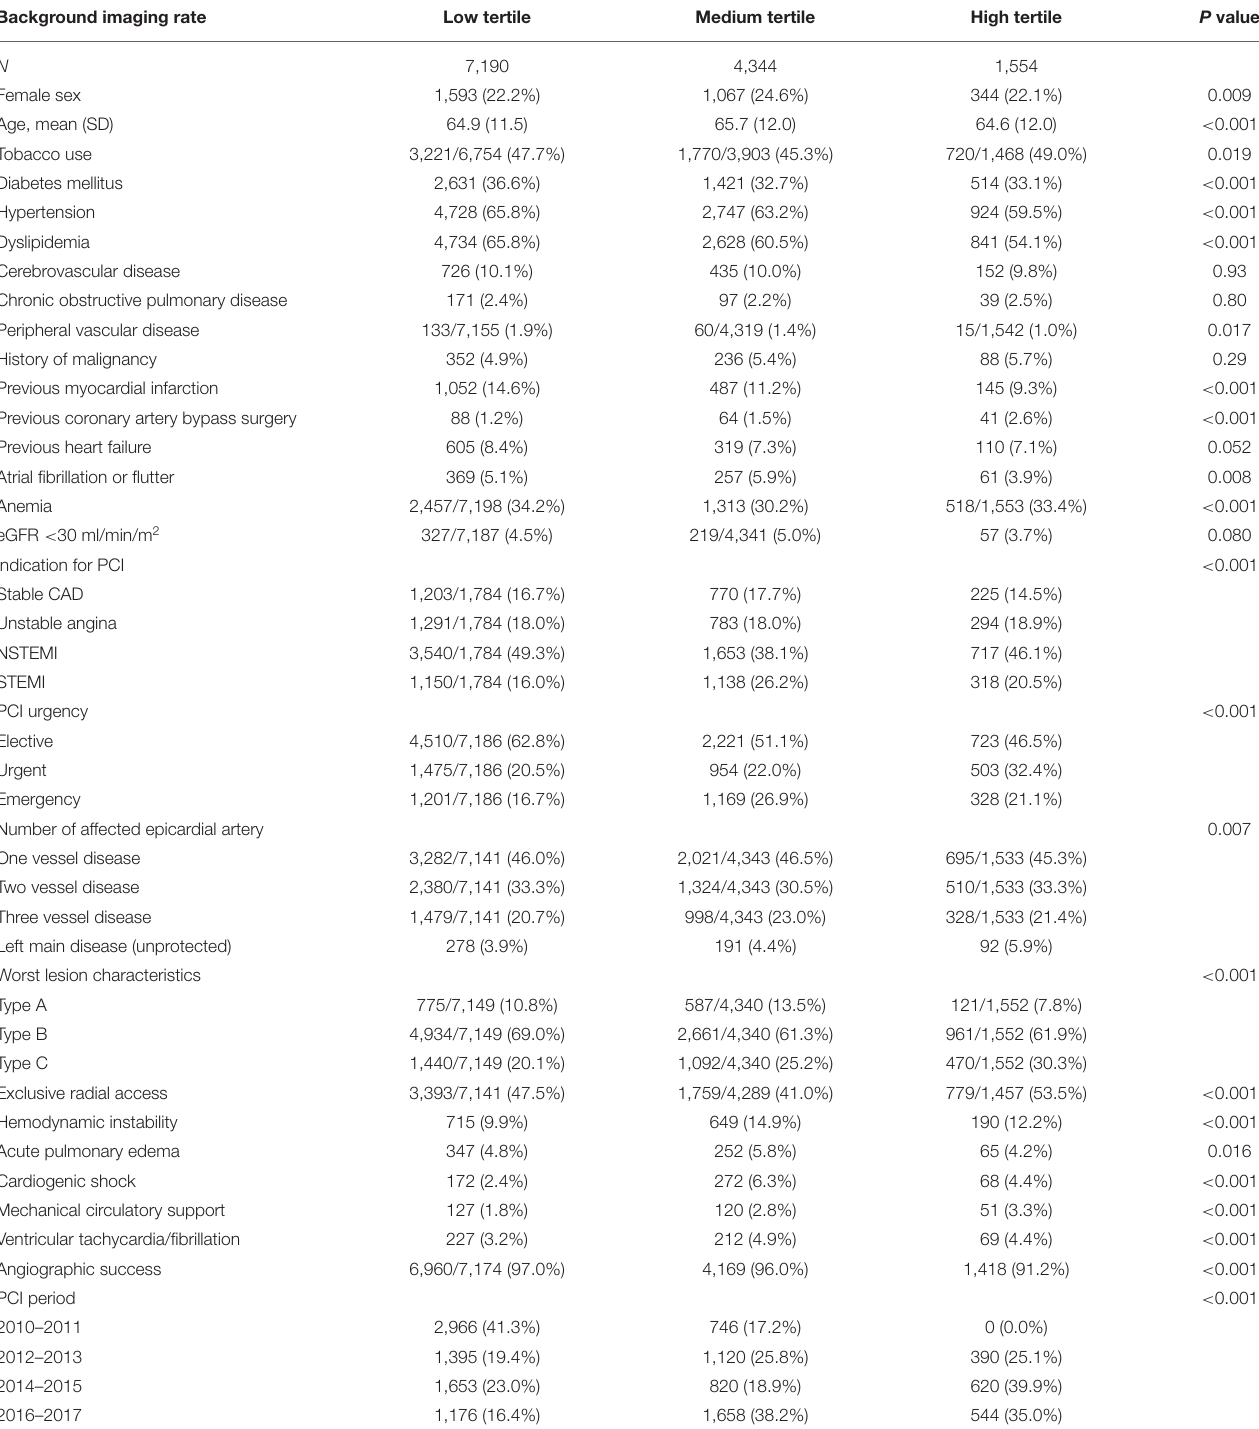
TABLE 2 | Baseline characteristics of patients undergoing angiography-guided PCI stratified by background imaging